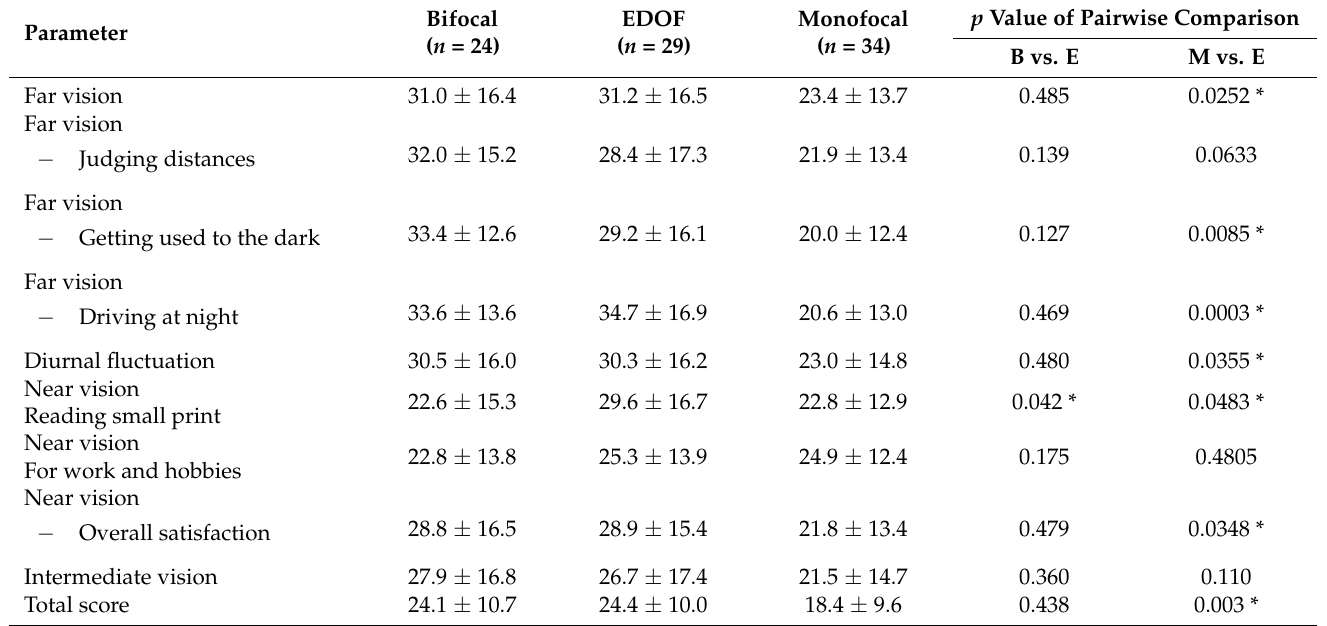
Table 5. Adjusted mean of score of 9 questions from quality of vision questionnaire and the total, and pairwise comparison with EDOF as